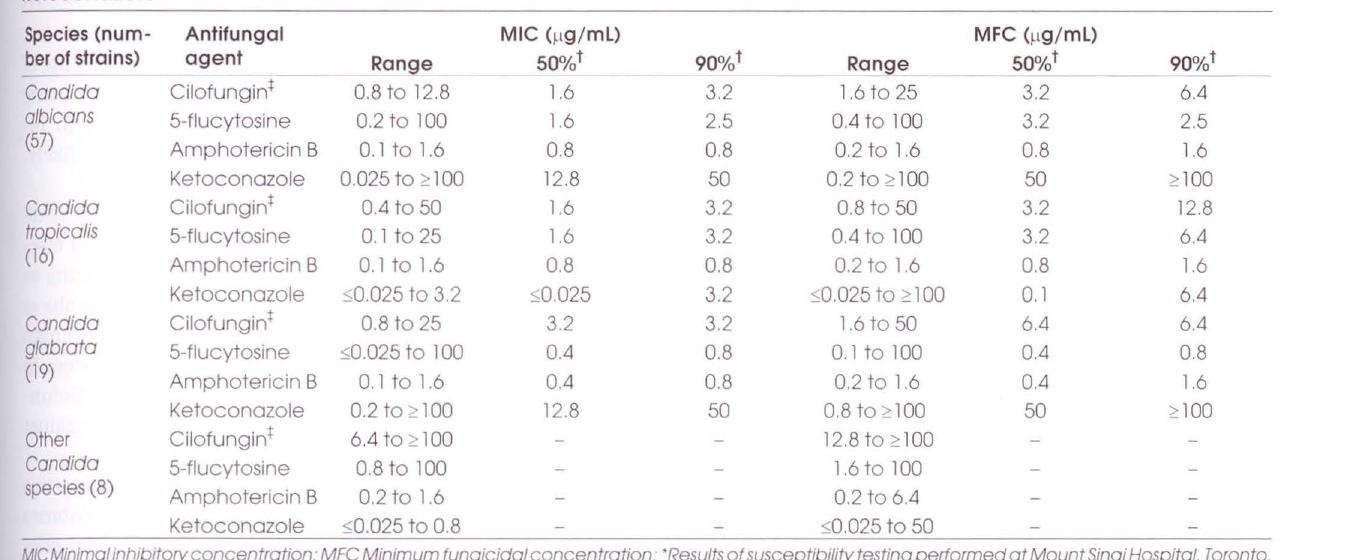
In vitro susceptibility of 100 clinical isolates of Candida species to cilofungin, 5-flucytosine, amphotericin Band ketoconazole*